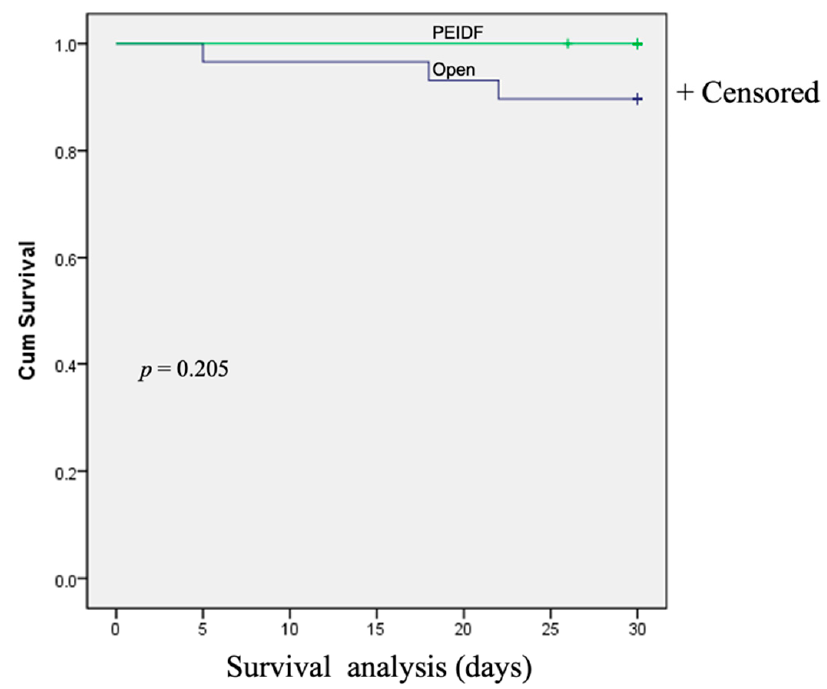
Figure 5. The Kaplan–Meier survival curve demonstrates the postoperative mortality within one month between the two groups.